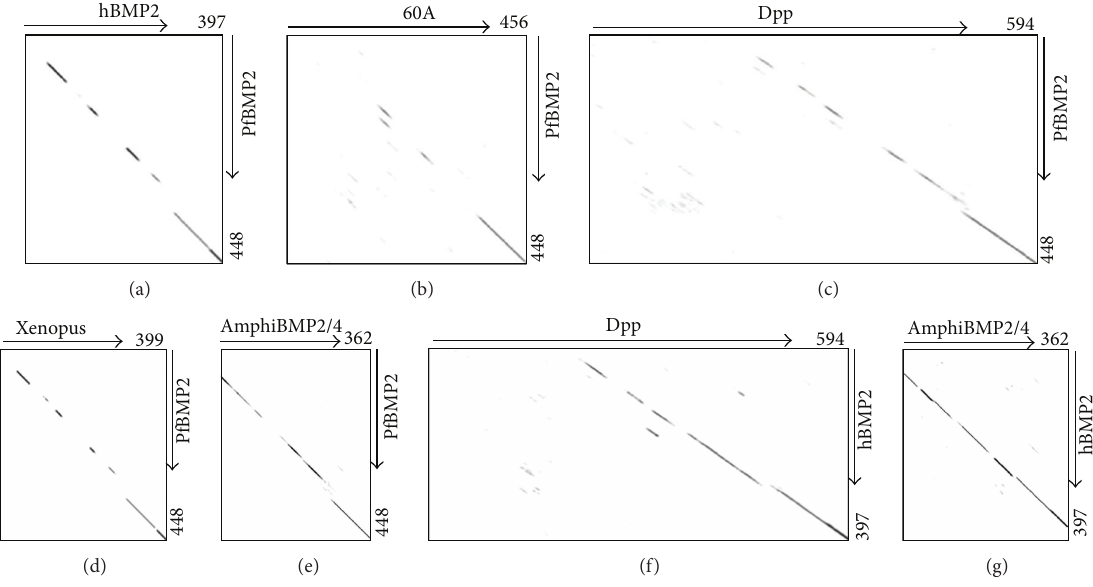
Figure 1: Dotlet comparison of Pf BMP-2 and other homologs. (a) Comparison of Pf BMP-2 with hBMP-2; (b) comparison of Pf BMP-2 with Drosophilidae 60A; (c) comparison of Pf BMP-2 with Drosophilidae Dpp; (d) comparison of Pf BMP-2 with Xenopus BMP-2; (e) comparison of Pf BMP-2 with AmphiBMP2/4; (f) comparison of hBMP-2 with Drosophilidae Dpp; (g) comparison of hBMP-2 with AmphiBMP2/4. The total number of amino acids is shown numerically. The thin lined arrow indicates the direction of the amino acid sequence from the N- to the C-terminus.AbbreviationswithGenBankaccessionnumberinparentheses;hBMP-2:humanBMP-2(NM001200); Pf BMP-2: Pinctada fucata BMP-2 (AB176952); Drosophilidae 60A: Drosophila transforming growth factor B-like protein (M77012); Dpp: Drosophila decapentaplegic protein (AF041439); Xenopus BMP-2: Xenopus laevis BMP-2 (NM001101666); AmphiBMP2/4: Branchiostoma floridae bone morphogenetic protein 2/4 (AF068750). Dotlet was performed at http://myhits.isb-sib.ch/cgi-bin/dotlet [17].